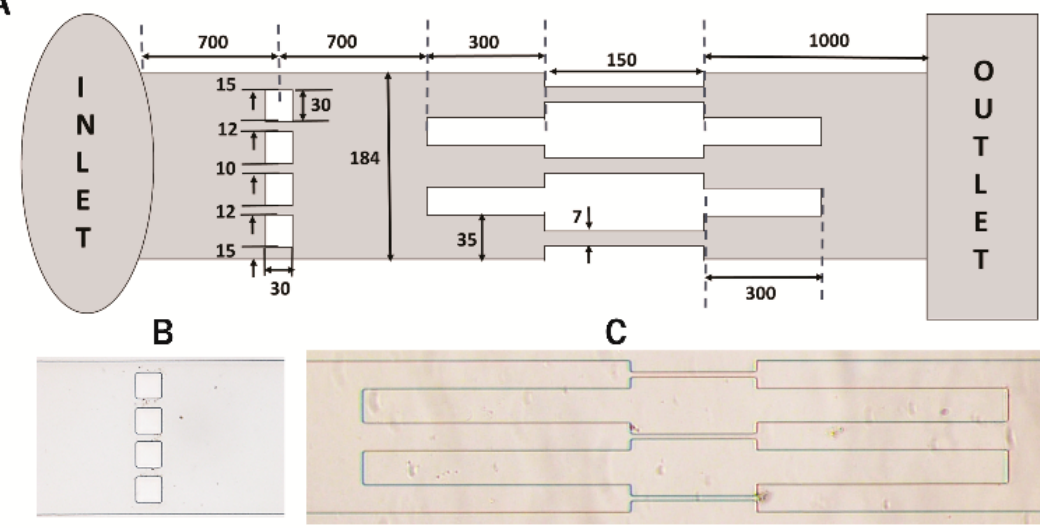
Figure 2. Design of the microchannel. ( A ) Schematic representation of the microchannel (not to scale); ( B ) magnified view of the 30 µ m blockages; ( C ) magnified view of the series of constricted channels. All dimensions in µ m.